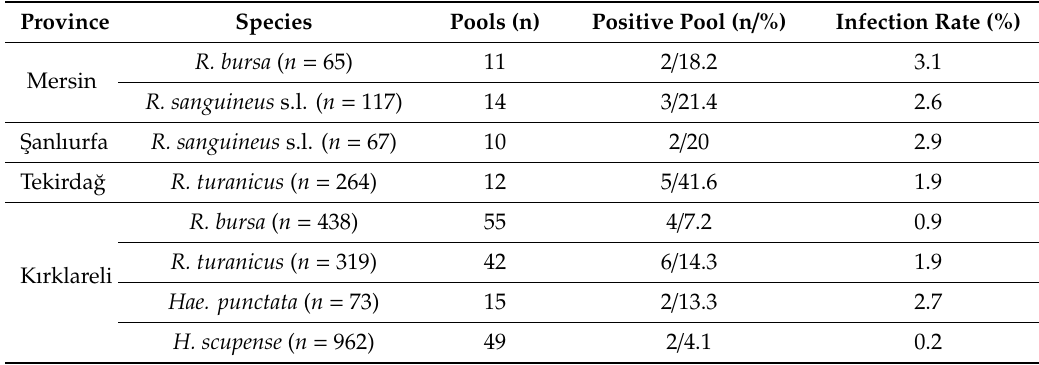
Table 1. Distribution of tick pools with detectable phleboviruses. The infection rate was calculated assuming a single infected specimen in each pool. All positive pools includ adult